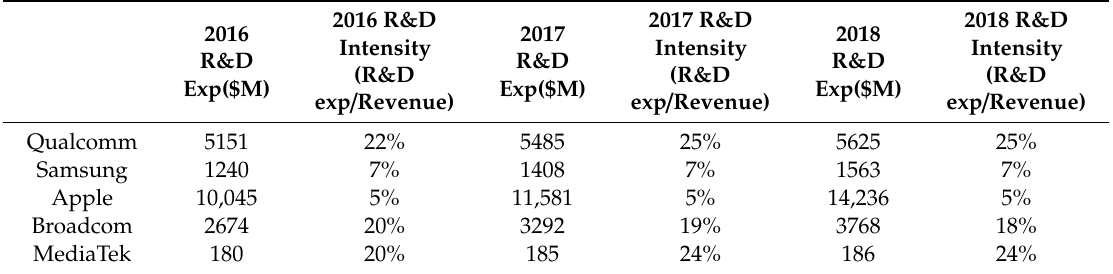
Table 4. R&D (Research and Development) expenses and R&D